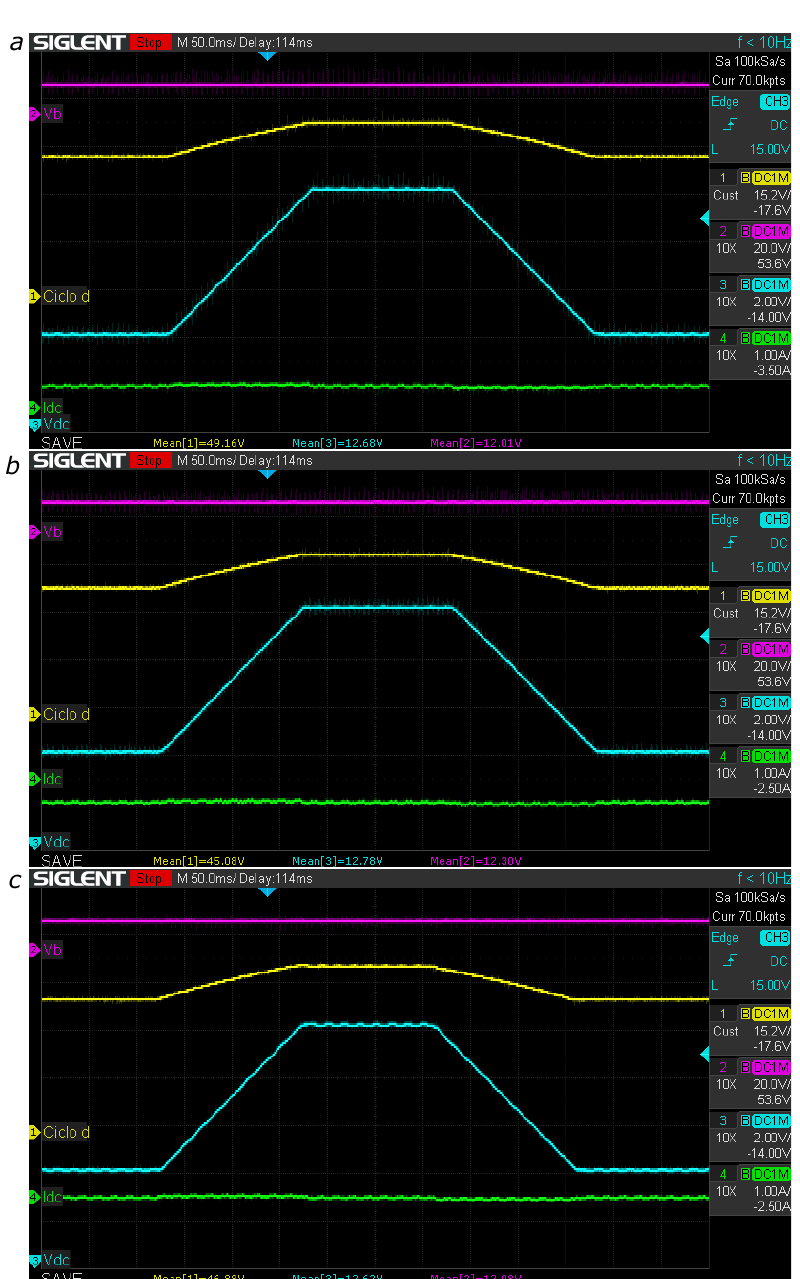
Figure 29. Reference tracking performance at V b = 12 V: ( a ) discharge mode, ( b ) charge mode, and ( c ) stand-by mode. Magenta: battery voltage V b ; yellow: duty cycle d ; cyan: bus voltage V dc ; and green: bus current i o